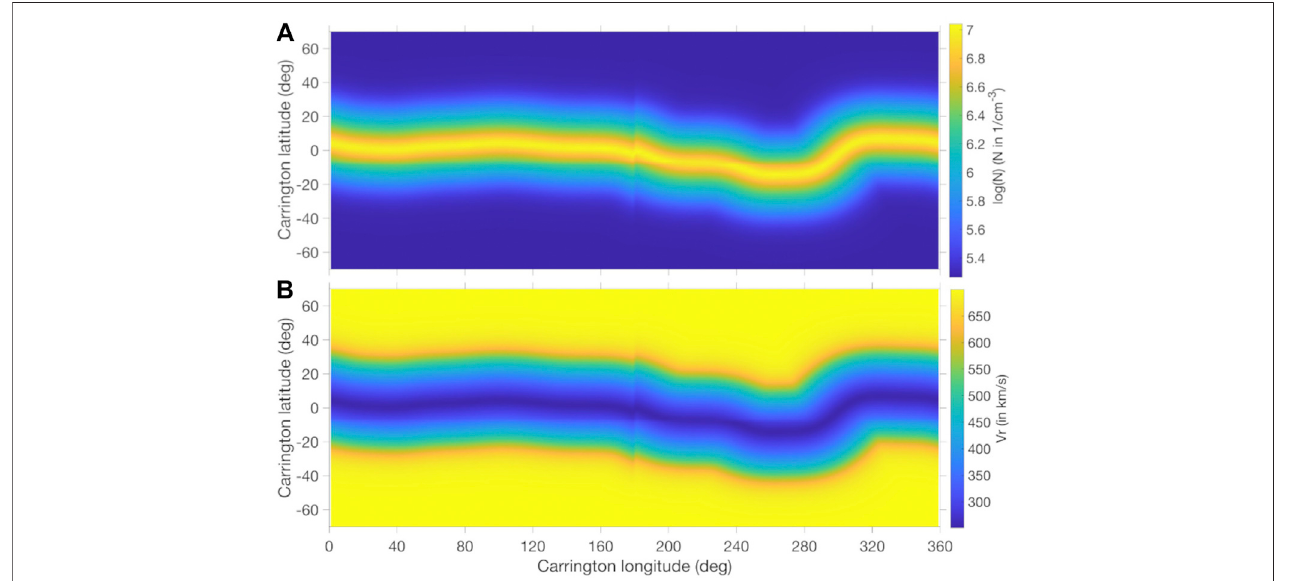
FIGURE 8 | 2-D maps of solar wind density (A) and radial velocity (B) determined from the SMB line extracted on the 2019-06-15 at 12:00 UTC from LASCO-C2 WL observations at 5 . 0 R ⊙ .